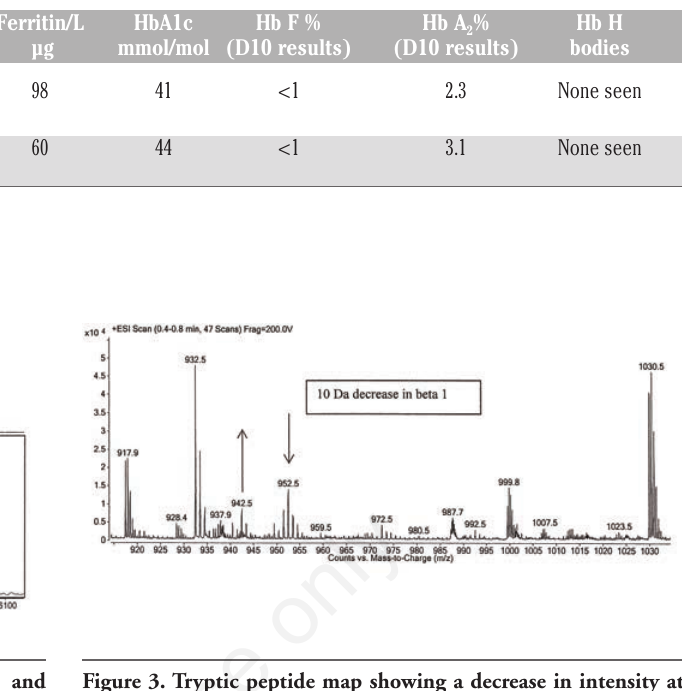
Table 1. Hematolgy and chemistry results for these reported cases of heterozygous Hb Tyne.